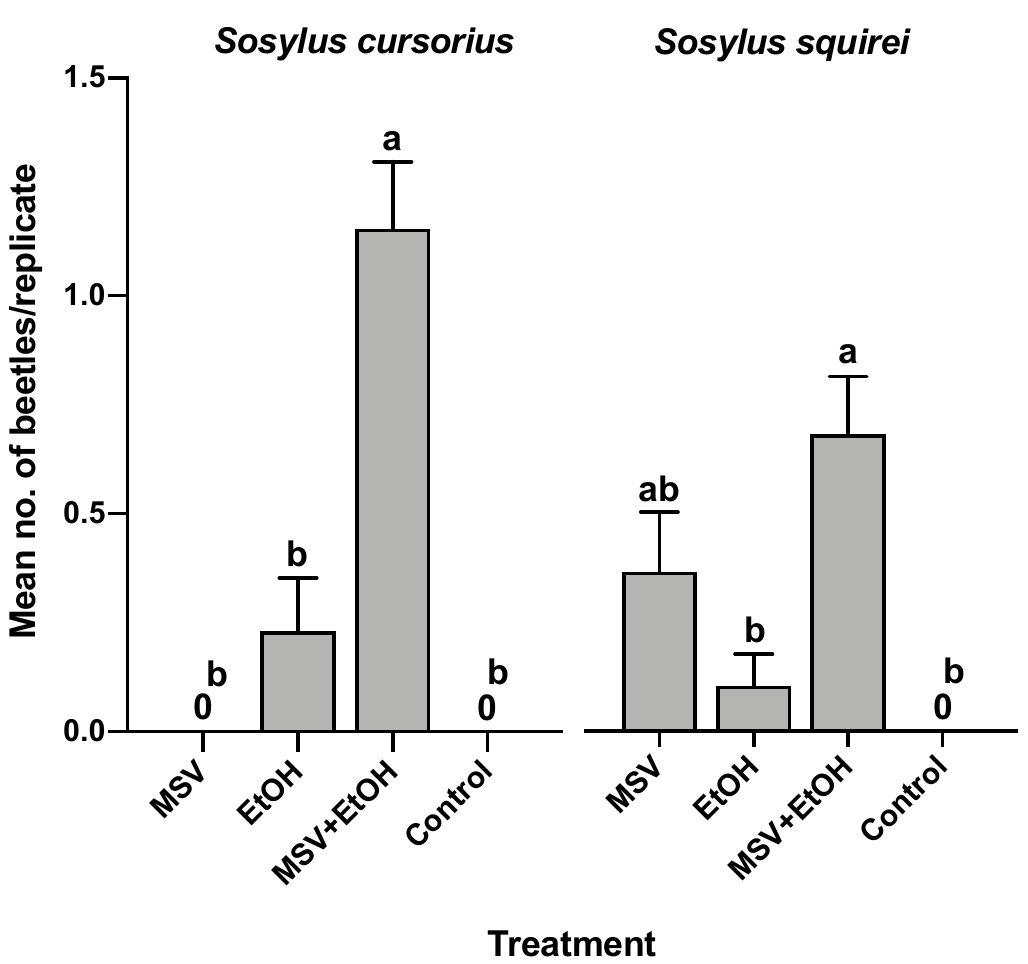
Figure 5. Mean ( ± SE) numbers of adults of Sosylus cf. cursorius and Sosylus squirei captured with traps containing synthetic male-specific volatile compounds of Euplatypus parallelus , in combination or not with ethanol. Treatment abbreviations: MSV = male-specific volatiles of E. parallelus , i.e., blend of 3-methyl-1-butanol, 1-hexanol, hexyl acetate, 1-octanol, and geraniol in the same ratio produced by conspecific males; EtOH = 99.5% ethanol; control = neat isopropanol. Type of attractant lure significantly affected the trap catch of S. cf. cursorius (Q 3, 52 = 36.1, p < 0.0001) and S. squirei (Q 3, 76 = 22.3, p < 0.0001). Means followed by same letter within a panel are not significantly different according to the Ryan-Einot-Gabriel- Welsch Q multiple range test at 5% probability.